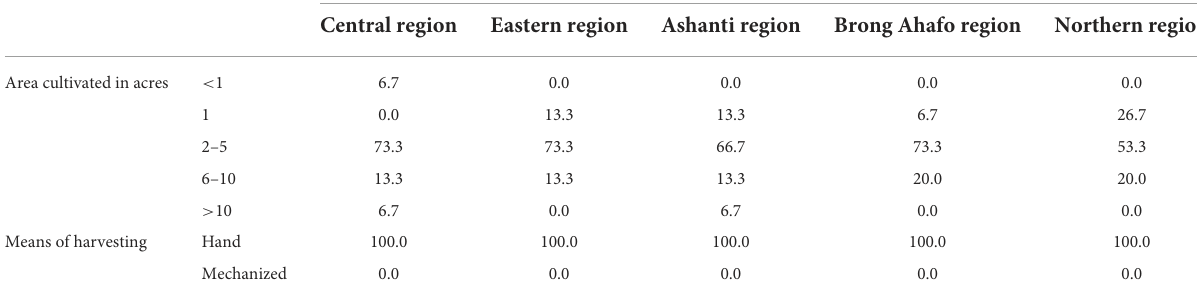
TABLE 3 Farm sizes cultivated by maize farmers, and the different methods of harvesting maize grain.